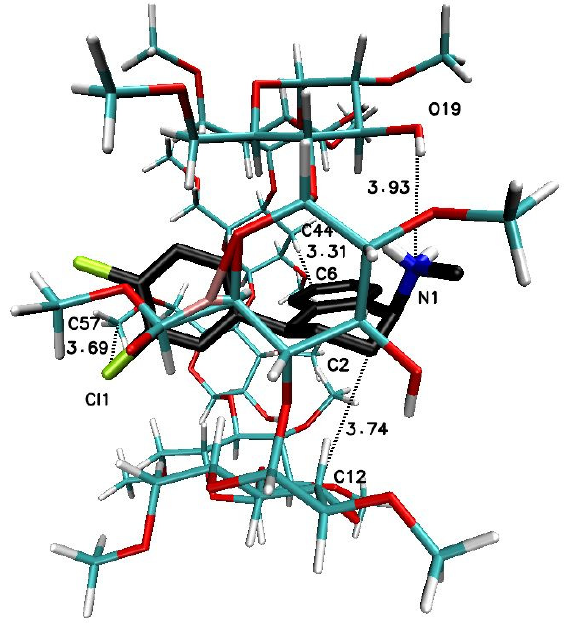
Figure 12. The geometry of the SRT-RM β CD complex with stoichiometry 1:1 obtained by MD sim- ulations with the use of RM β CD crystal structure with refcode JOSWOD [48] from the CSD database